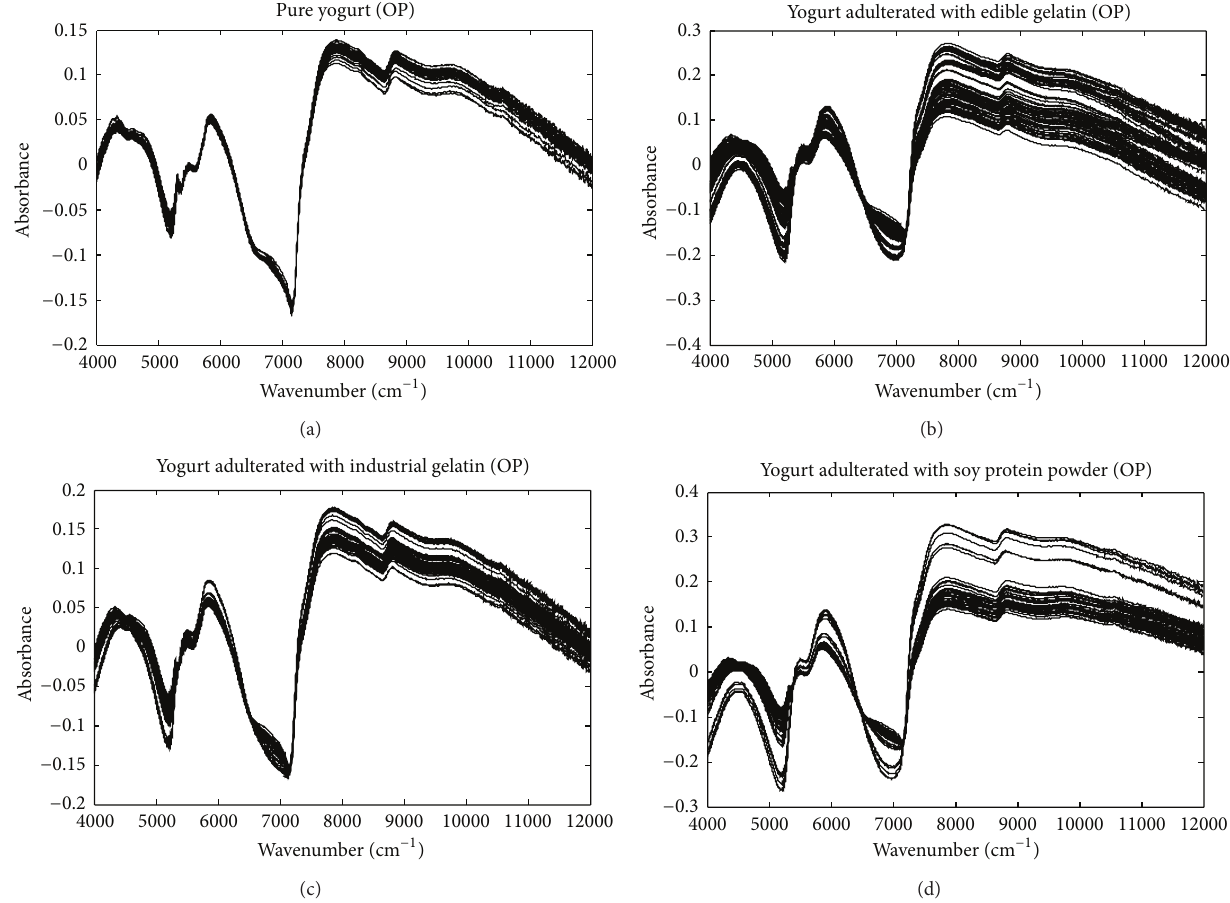
Figure 4: Typical orthogonally projected (OP) NIR spectra of yogurt objects adulterated with different levels of edible gelatin, industrial gelatin, and soy protein powder. All the spectra were projected onto the orthogonal complement space of water